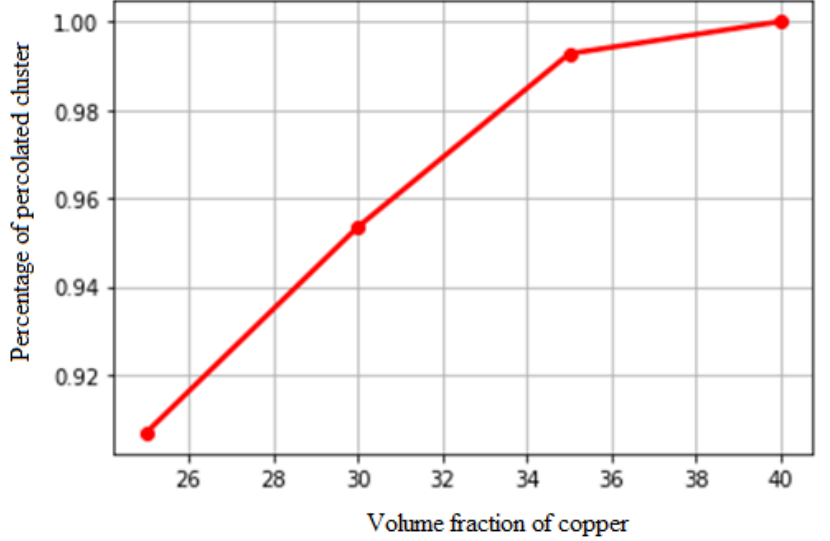
Figure 12. The effect of the copper VF on the largest cluster size is divided by the microstructure size (vertical axis).